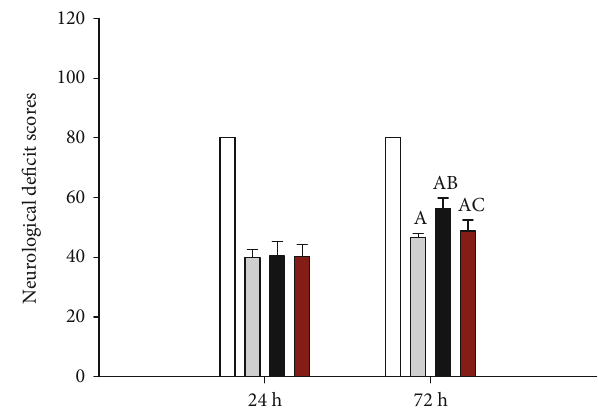
Figure 3: NDS after ROSC. The NDS were measured by evaluating the behavior of the rats at 24 and 72 hours after ROSC. Data are presented as mean ± SD . A P < 0 : 05 vs. sham group; AB P < 0 : 05 vs. saline group; AC P < 0 : 05 vs. Ac2-26 group (, sham group; , saline group; , Ac2-26 group; , Ac2-26+L-NIO group).